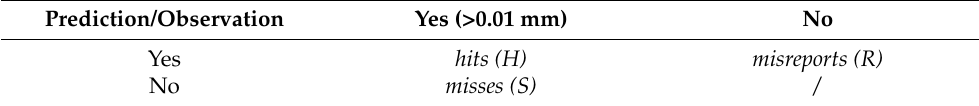
Table 6. Rain/no rain contingency table for the WRF simulation against observation.